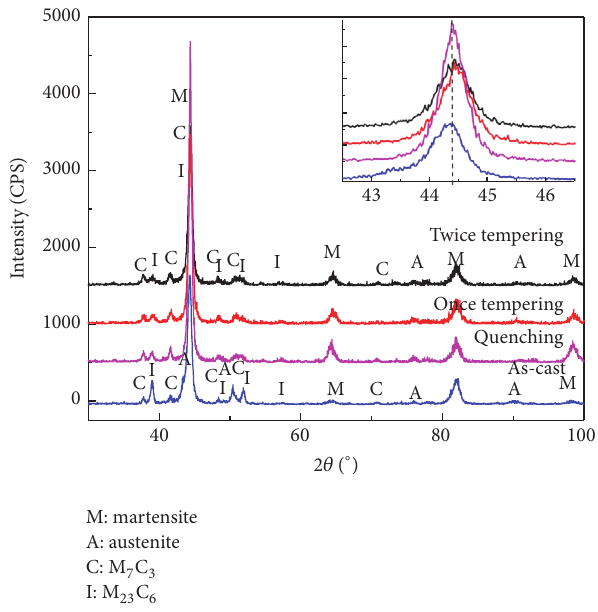
Figure 2: X-ray diffractometer patterns of the HCCI as-cast and after different heat treatments.